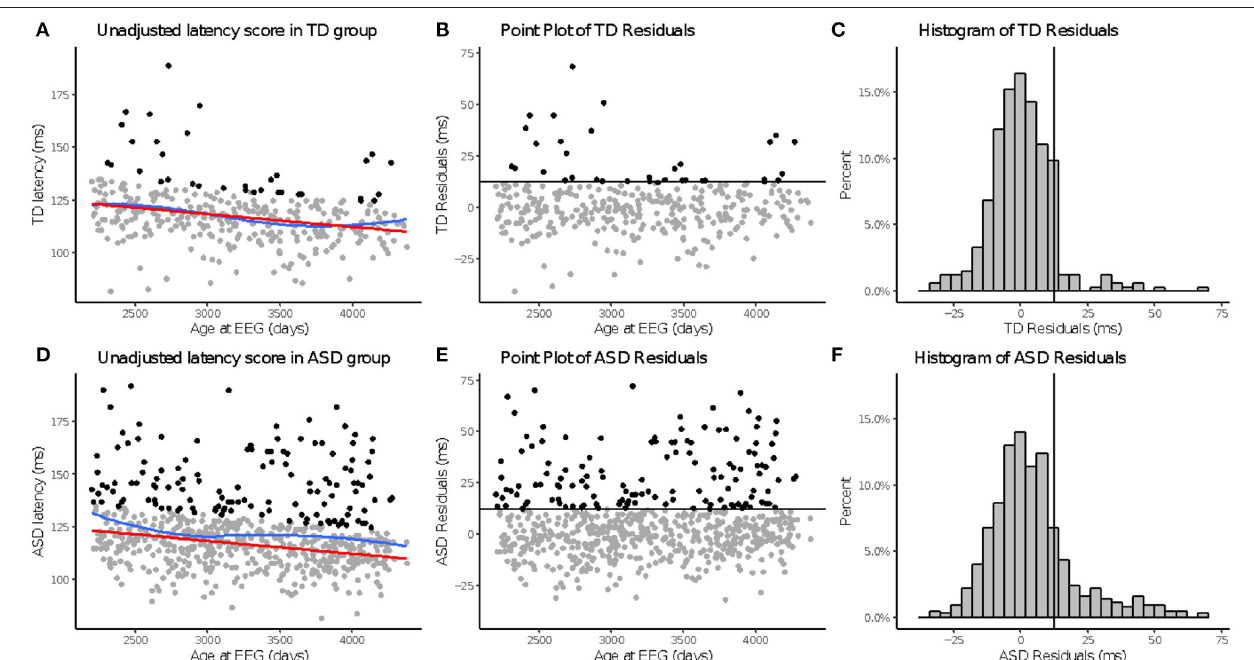
FIGURE 3 | a P100 latency to upright faces. Age-adjusted P100L in response to upright faces. Graphs depict the TD group in the top row (A–C) and ASD in the bottom row (D–F) . (A,D) : The red line in column 1 indicates predicted values of P100L based on the fitted model, while the blue line indicates the locally estimated scatterplot smoothing (LOESS) for each group. (B,E) : Graphs show the residuals values calculated using the fitted model. (C,F) : Black lines indicate a cutoff point derived from the upper 10% of all age-adjusted P100L scores in the TD group. Data points greater than that cutoff point are also in black (A,B,D,E)